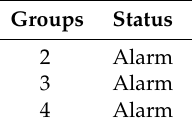
Table 2. The results of empty belt images from groups 2 to 4, as processed by our